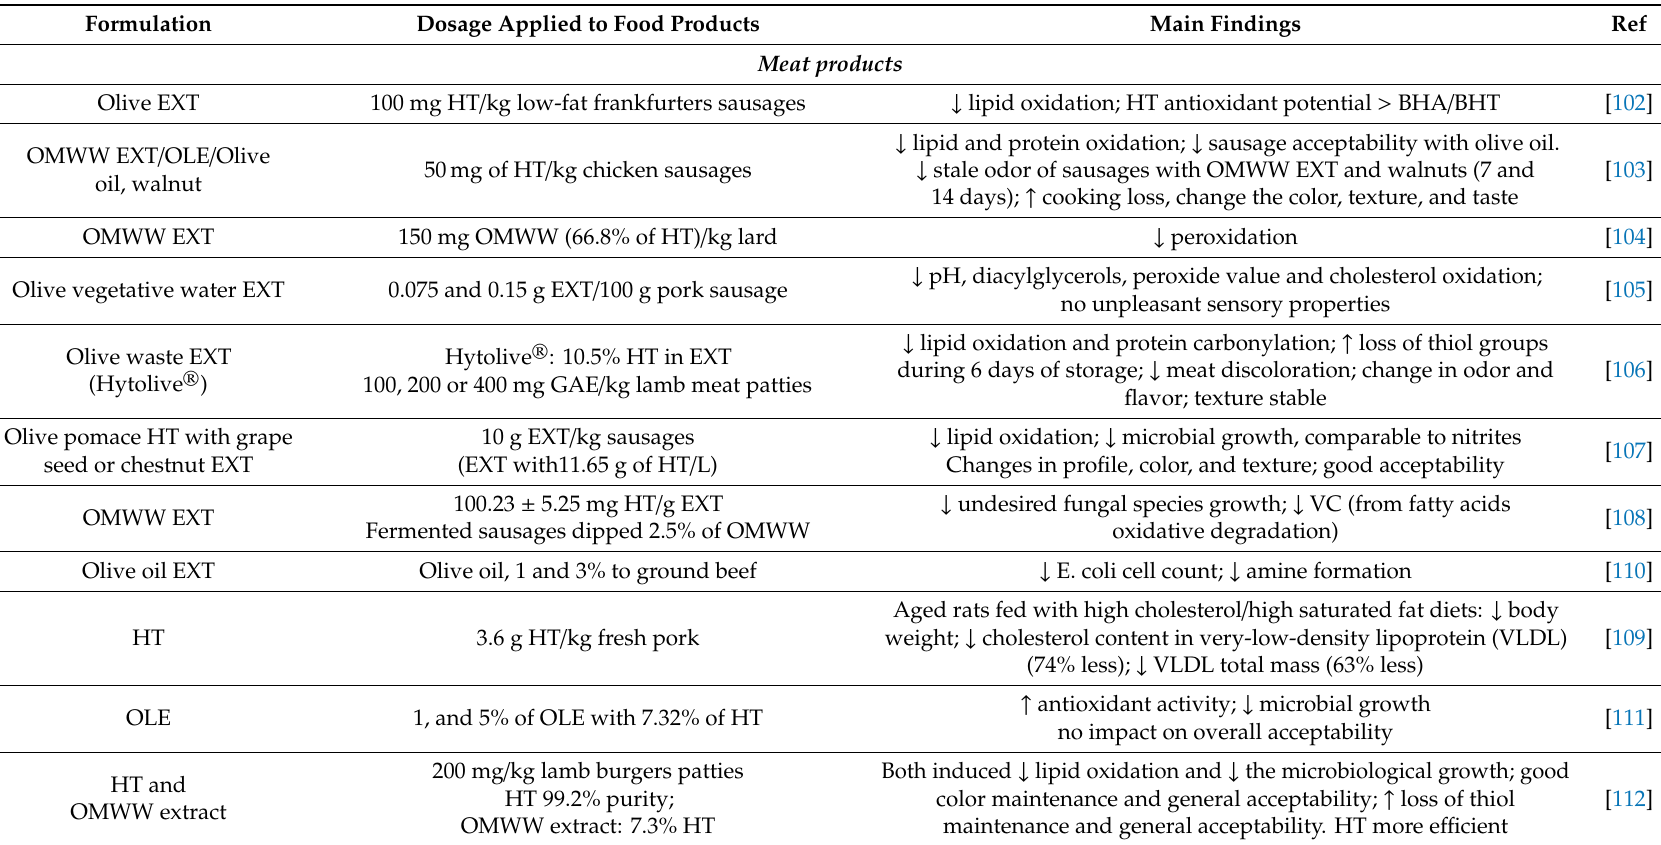
Table 2. Applicability of free or extract-based HT on animal-based products and its e ff ect on product